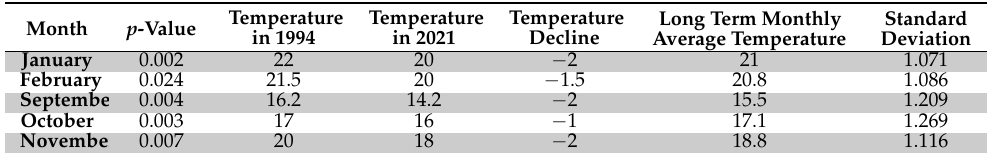
Table 2. Months with significant temperature decrease in ◦